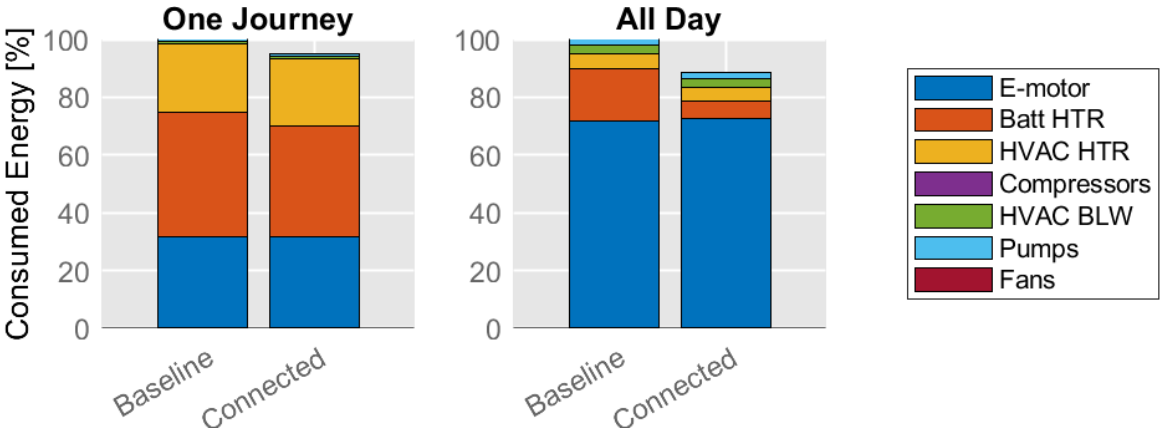
Figure 22. Global energy balance of the electric bus for both configurations of thermo-hydraulic circuits.